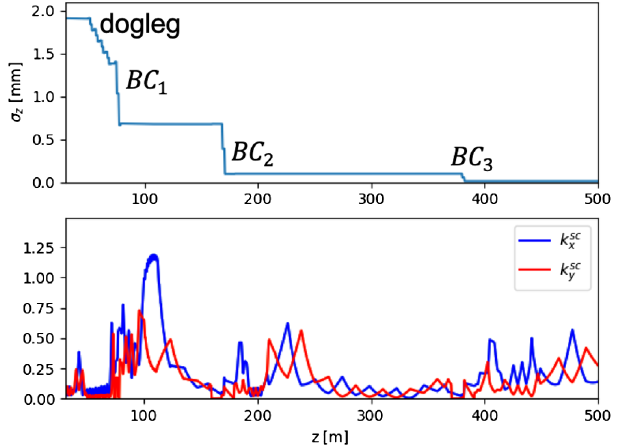
FIG. 6. The bunch length and the space charge parameter along the accelerator (after the laser heater, z ¼ 30 m, up to a position in the main linac, z ¼ 500 m) for the bunch charge of 500 pC compressed to the peak current of 5 kA.